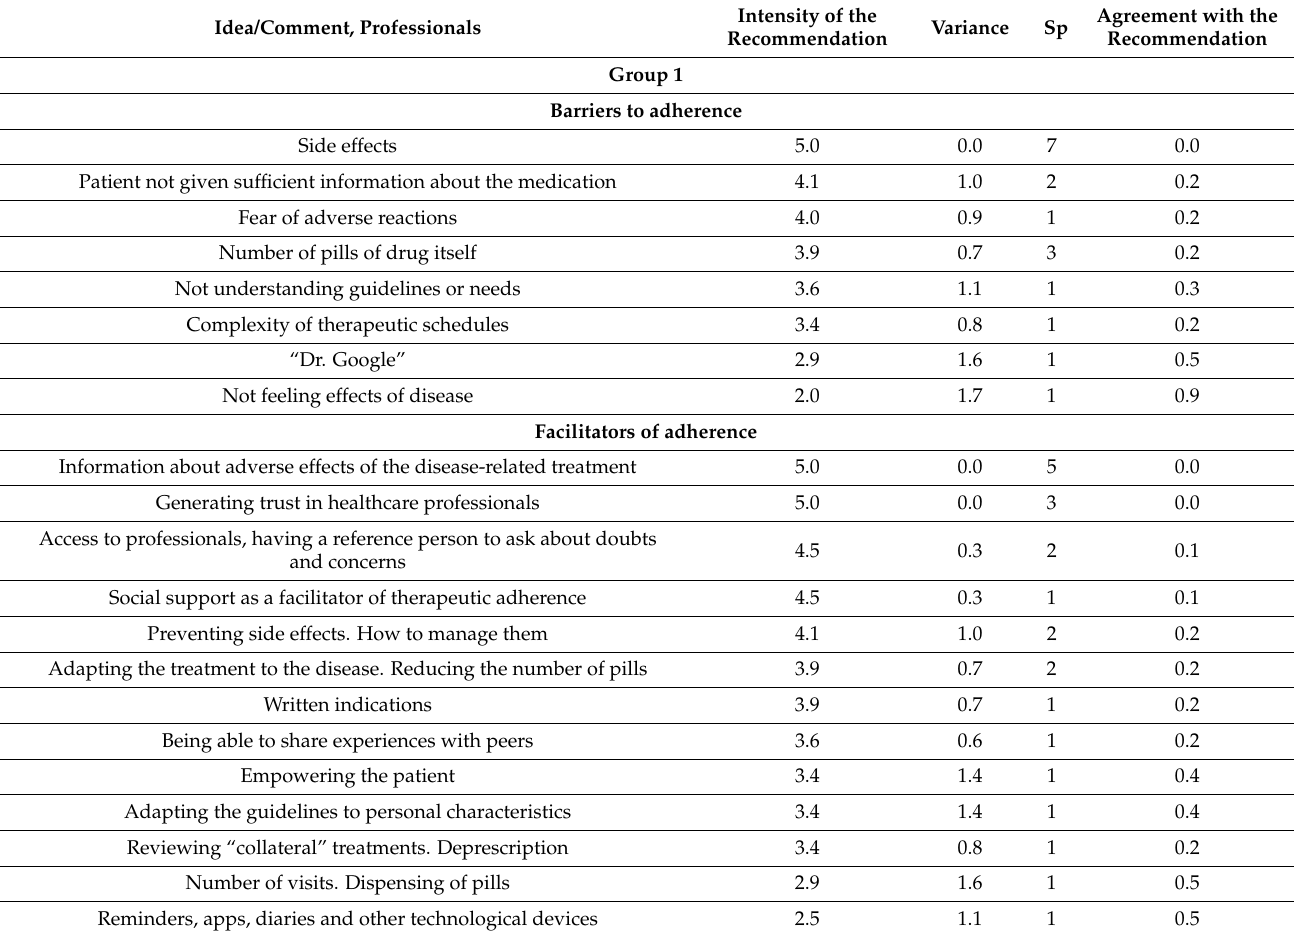
Table A4. Nominal group results, professionals. Group work